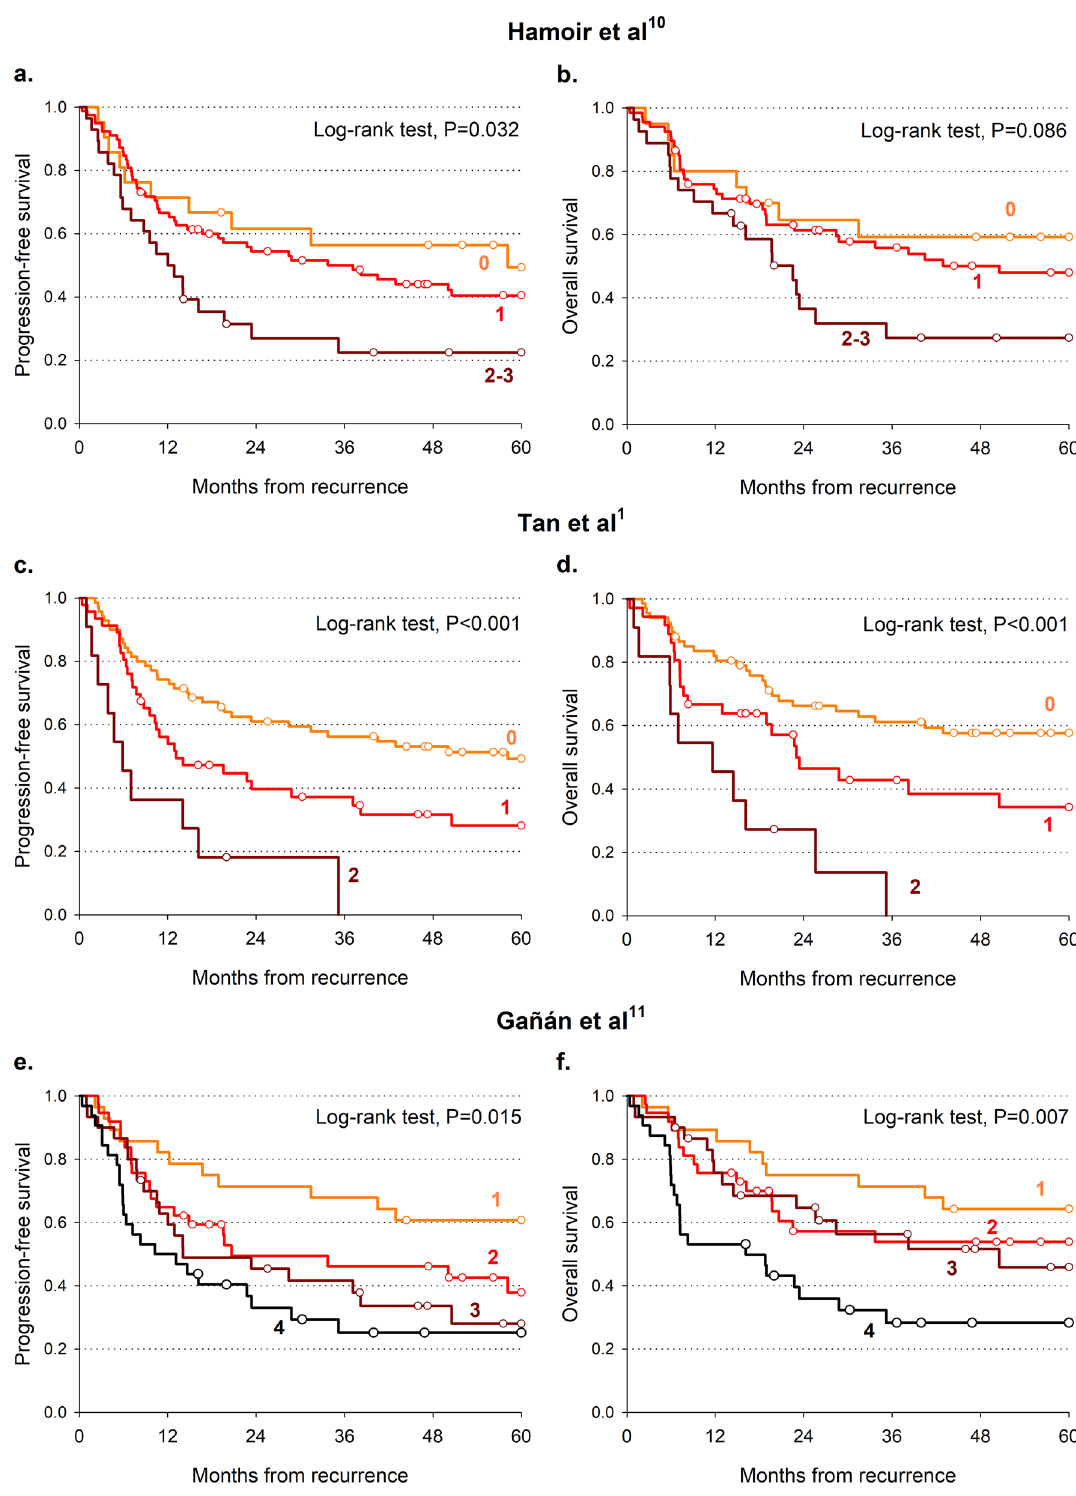
Figure 2. Progression-free survival ( a , c , e ) and overall survival ( b , d , f ) according to published prognostic scores. Survival curves were estimated according to Kaplan–Meier methods, and differences across score levels were evaluated through log-rank